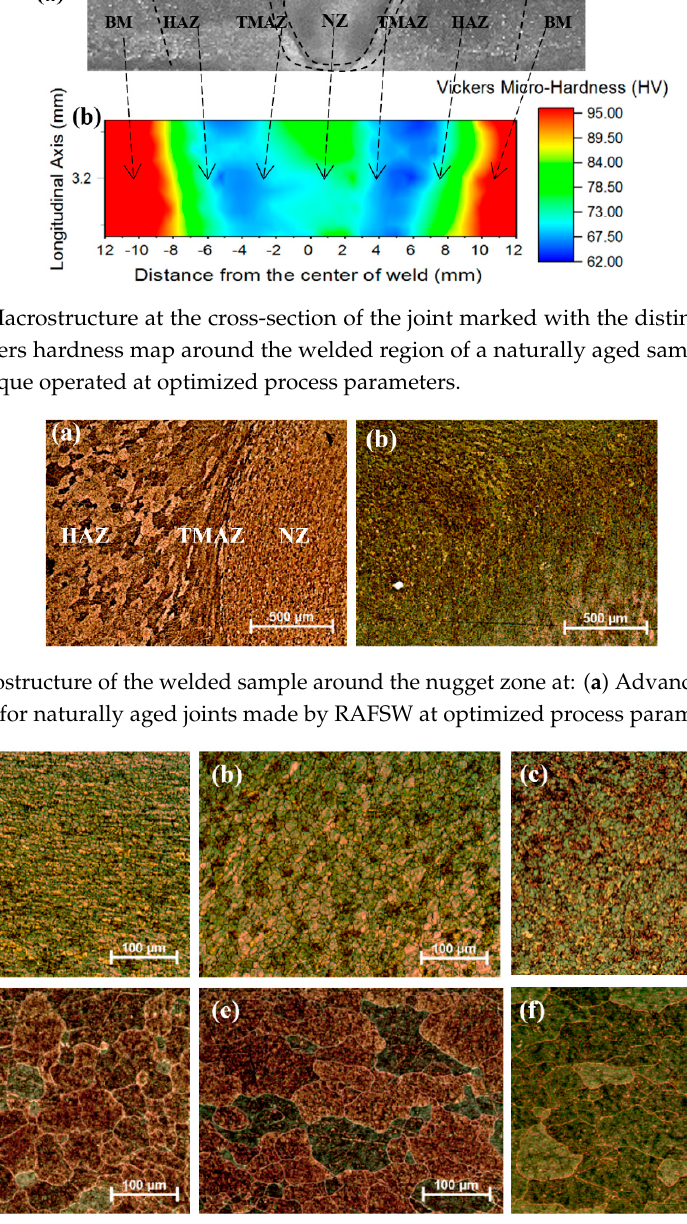
Figure 6. Microstructure of: ( a ) Top; ( b ) middle; ( c ) and bottom of the nugget zone (NZ); ( d ) base material; ( e ) the heat-affected zone ( HAZ) area far from the weld region; ( f ) and the HAZ area near the NZ for naturally aged joints made by RAFSW.